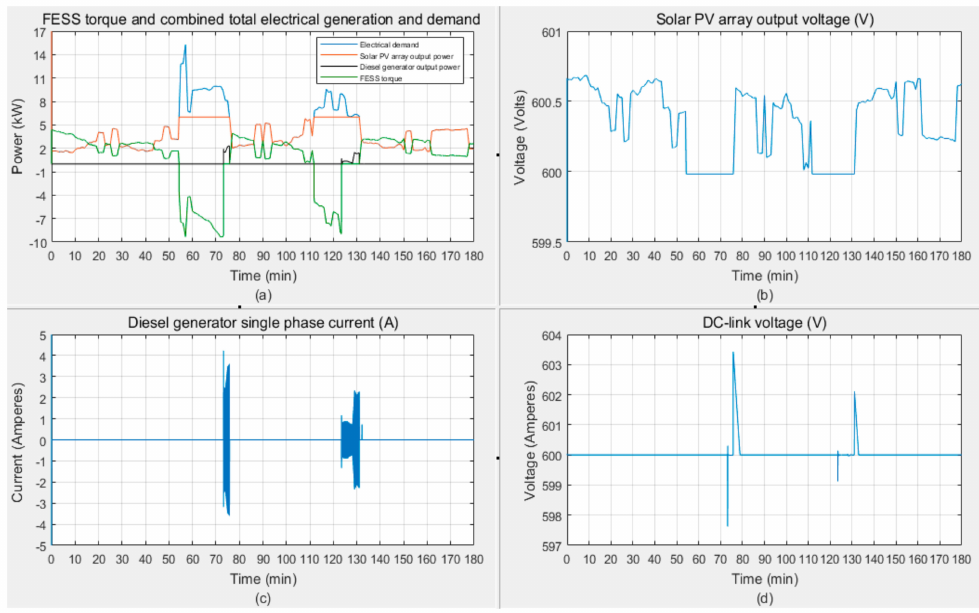
Figure 26. ( a ) Combined operation of the FESS, DGen, and PV system. ( b ) PV array output power. ( c ) Diesel generator current. ( d ) DC-link